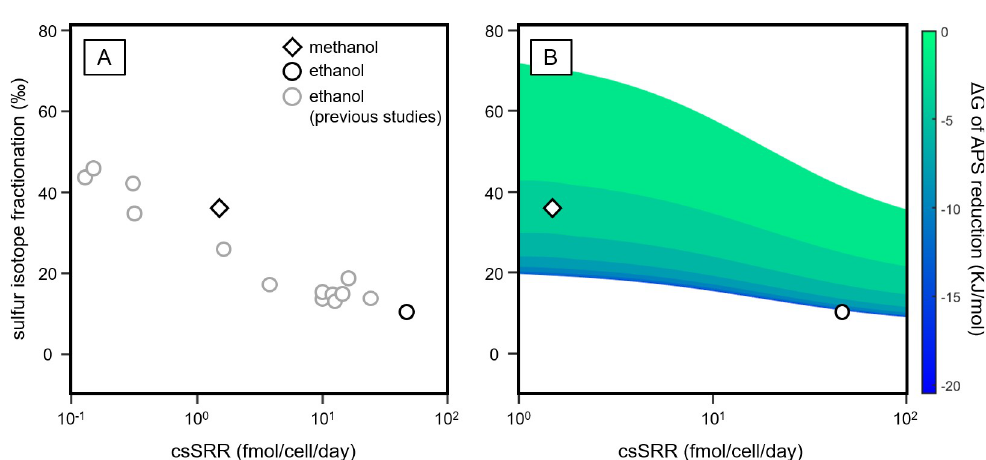
respiration rate normalized by optical density is converted to the approximate cell-specific sulfate reduction rate (csSRR) according to the conversion factor for optical density to total cell volume (A660 of 1.0 as 1.49 μ l/ml [52]) and the